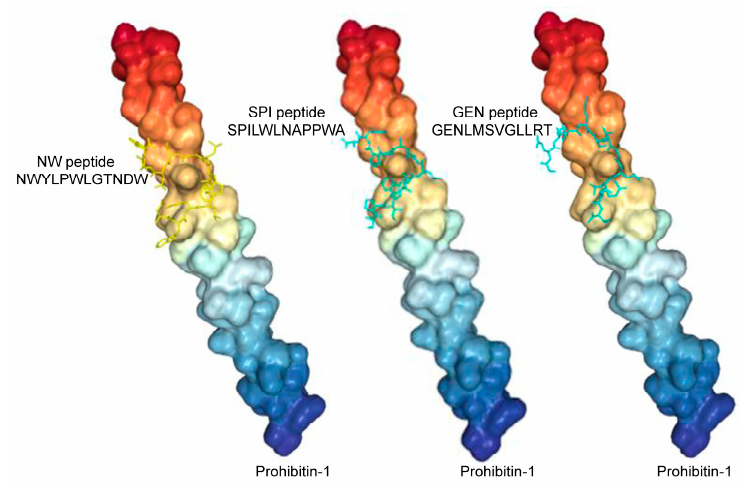
Figure 4. Representative docking results showing the predicted prohibitin-1 binding sites for the peptides. Several of the high affinity peptide predicted 3D structures bind to the same area. Protein style = surface; peptide style = licorice. Table 1. Sequences of the phage-displayed peptides.